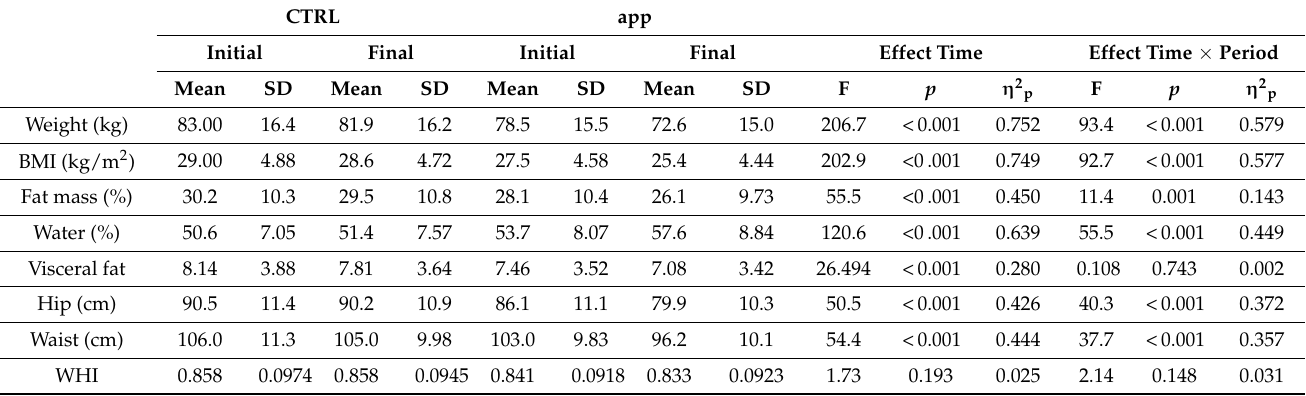
Table 4. Descriptive data (mean ± standard deviation) of body composition variables. Effect of the intervention (ANOVA) on blood pressure variables.